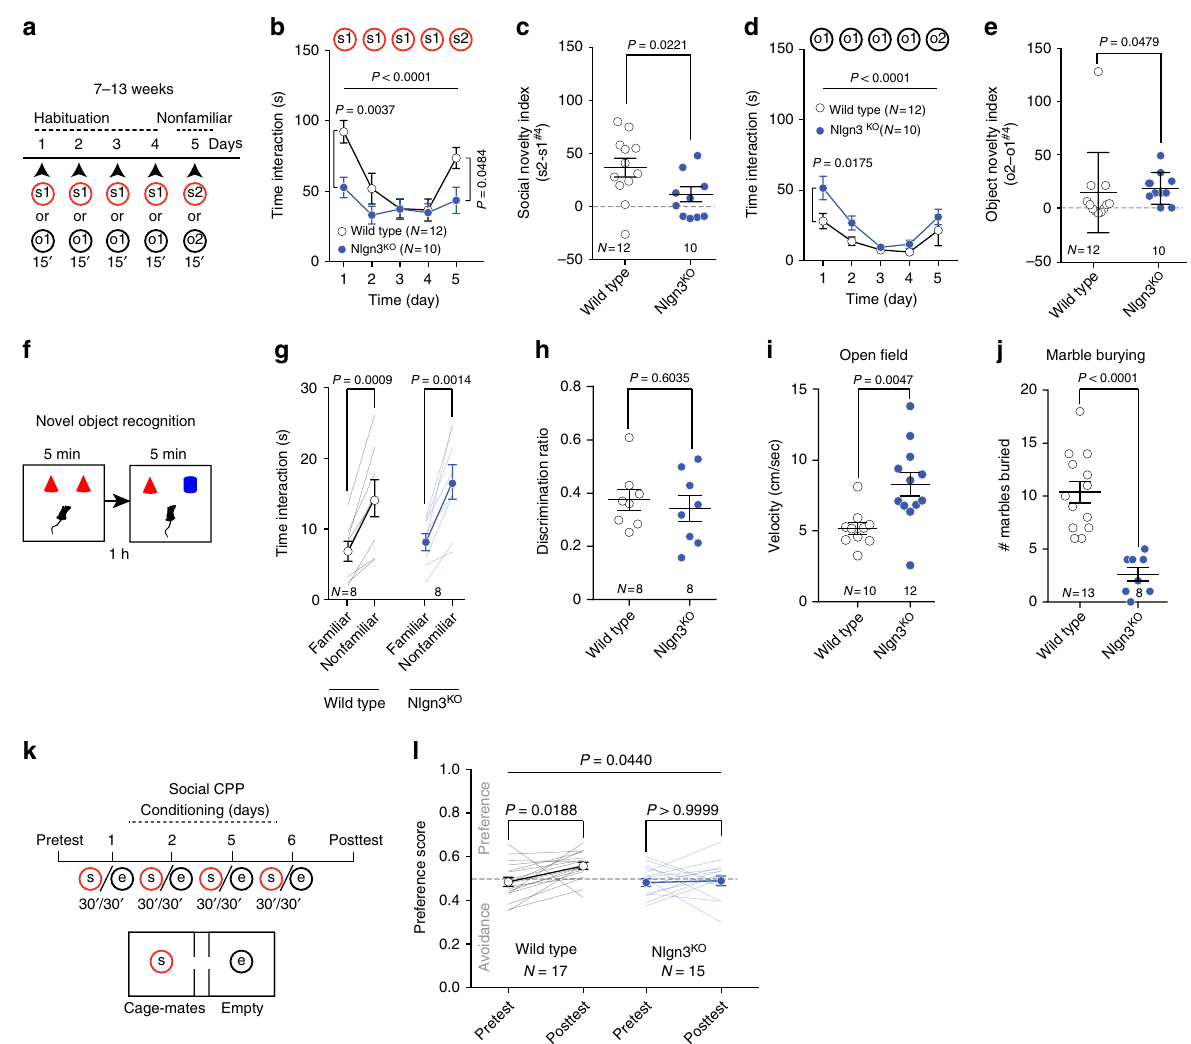
Fig. 4 Global knockdown of Nlgn3 alters sociability and social reward behaviors. a Experimental time-course for the habituation/nonfamiliar exploration task. b Mean social interaction time for wild type (WT) and Nlgn3 KO mice. RM two-way ANOVA (time main effect: F (4, 80) = 20.3, P < 0.0001; genotype main effect: F (1, 20) = 3.629, P = 0.0713; time × genotype interaction: F (4, 80) = 6.071, P = 0.0003) followed by Bonferroni ’ s post hoc test. c Social novelty index of WT and Nlgn3 KO mice. Unpaired t test (t (20) = 2.481). d Mean object interaction of WT and Nlgn3 KO mice. RM two-way ANOVA (time main effect: F (4, 80) = 17.07, P < 0.0001; genotype main effect: F (1, 20) = 3.858, P = 0.0636; time × genotype interaction: F (4, 80 ) = 1.715, P = 0.1547) followed by Bonferroni ’ s post hoc test. e Dot plot of object novelty index for WT and Nlgn3 KO mice. Mann – Whitney U = 30. f Schematic of novel object recognition test. g Time spent investigating a novel and a familiar object. Paired t test (WT: t (7) = 5.494. Mean and s.e.m familiar = 6.841 ± 1.41, mean and s.e.m novel = 14.33± 2.617. KO: t (7) = 5.12. Mean and s.e.m familiar = 8.115 ± 1.186, mean and s.e.m novel = 16.63 ± 2.441). h Object discrimination ratio for WT and Nlgn3 KO mice. Unpaired t test ( t (14) = 0.5314). i Mean velocity of WT and Nlgn3 KO mice during a 7 min-open fi eld test. Unpaired t test (t (20) = 3.178). j Number of marbles buried for WT and Nlgn3 KO mice. Unpaired t test ( t (19) = 5.505). ( k ) Schematics of the social conditioned place preference (CPP) test. l Scatter plot of preference score measured during the Pre- and Post-TEST for WT (mean and s.e.m for Pre-TEST: 0.4846 ± 0.0209; mean and s.e.m for Post-TEST: 0.5578 ± 0.0158), and Nlgn3 KO mice (mean and s.e.m for Pre-TEST: 0.4809 ± 0.0178; mean and s.e.m for Post-TEST: 0.4886 ± 0.0225). RM two-way ANOVA (time main effect: F (1, 30) = 4.422, P = 0.0440; genotype main effect: F (1,30) = 3.492, P = 0.0715; time × genotype interaction: F (1,30)